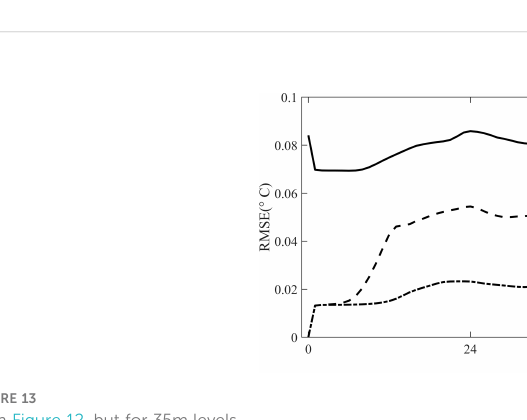
FIGURE 13 As in Figure 12, but for 35m